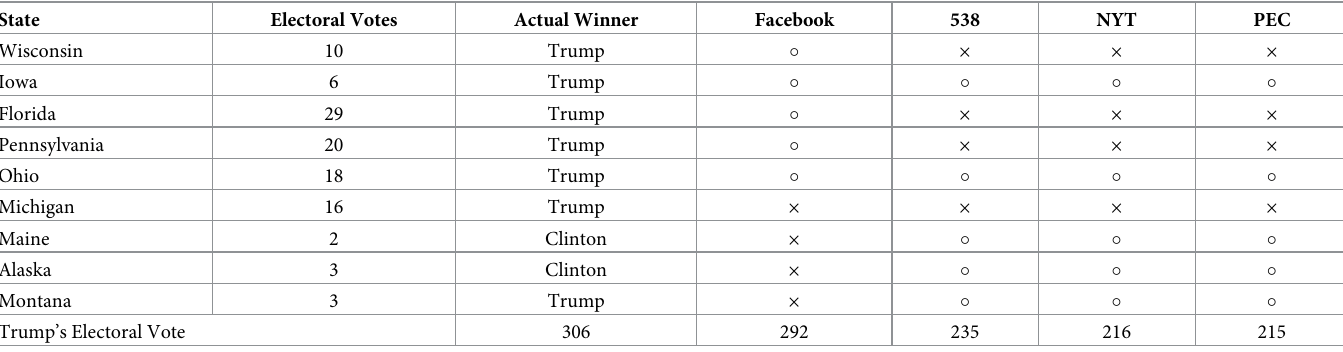
Table 4. Election forecasts comparison.